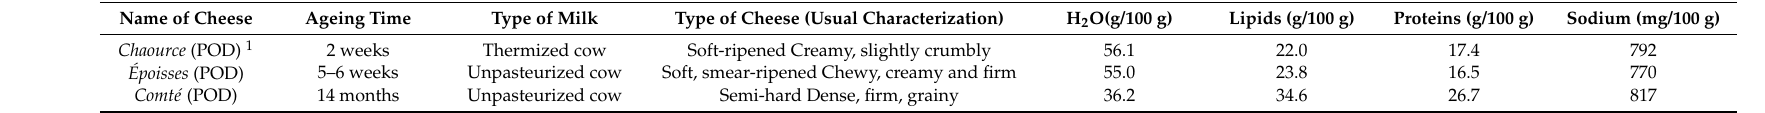
Table 1. Evaluated cheese samples.